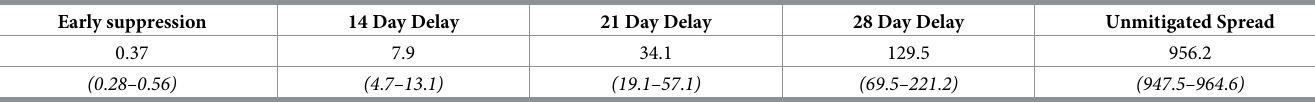
Table 1. A-VSL mortality estimates by scenario ($ billion AUD). Early